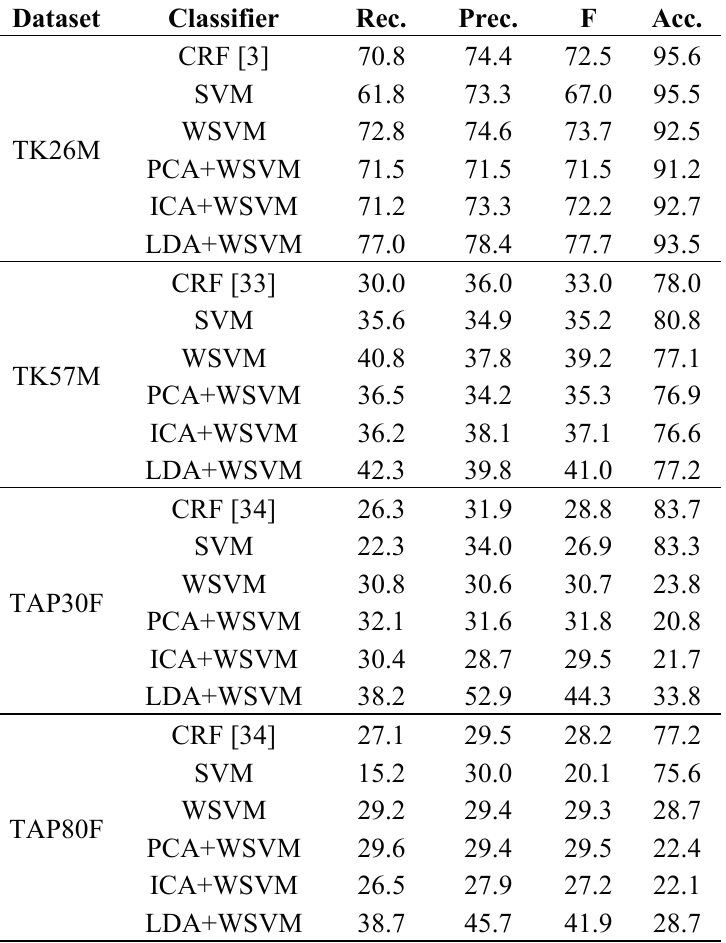
Figure 3. Feature selection by Linear Discriminant Analysis (LDA). Table 7. Recall (Rec.), Precision (Prec.), F-measure (F), and Accuracy (Acc.) results for all methods. The values are